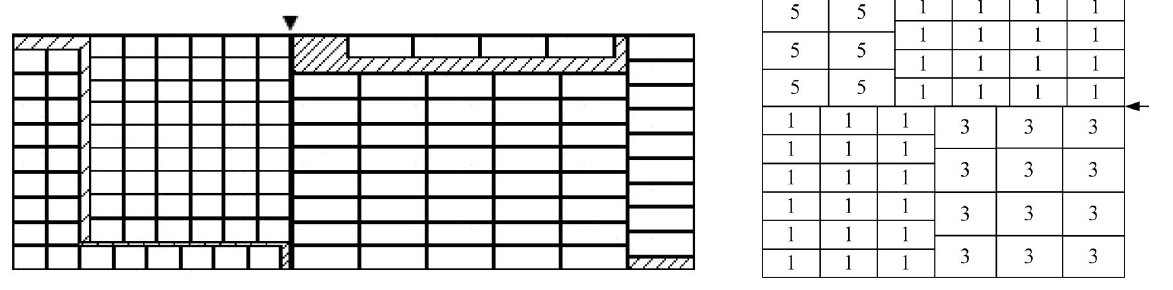
Figure 3. The cutting process of composite